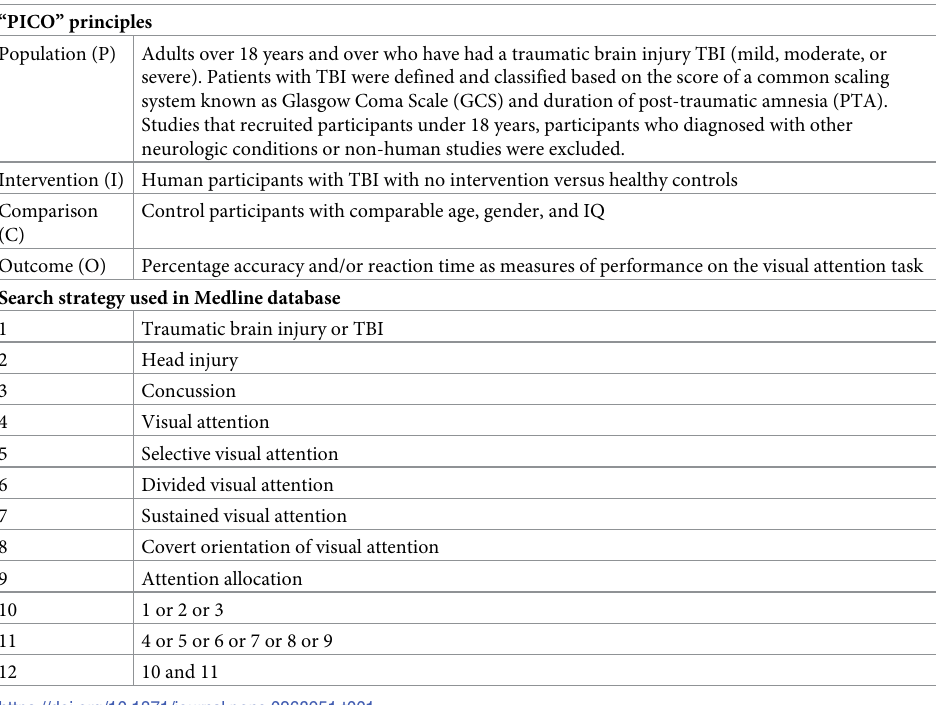
Table 1. PICO principles and Medline search strategy employed in the present review and in accordance with the PRISMA statement. “PICO” principles Population